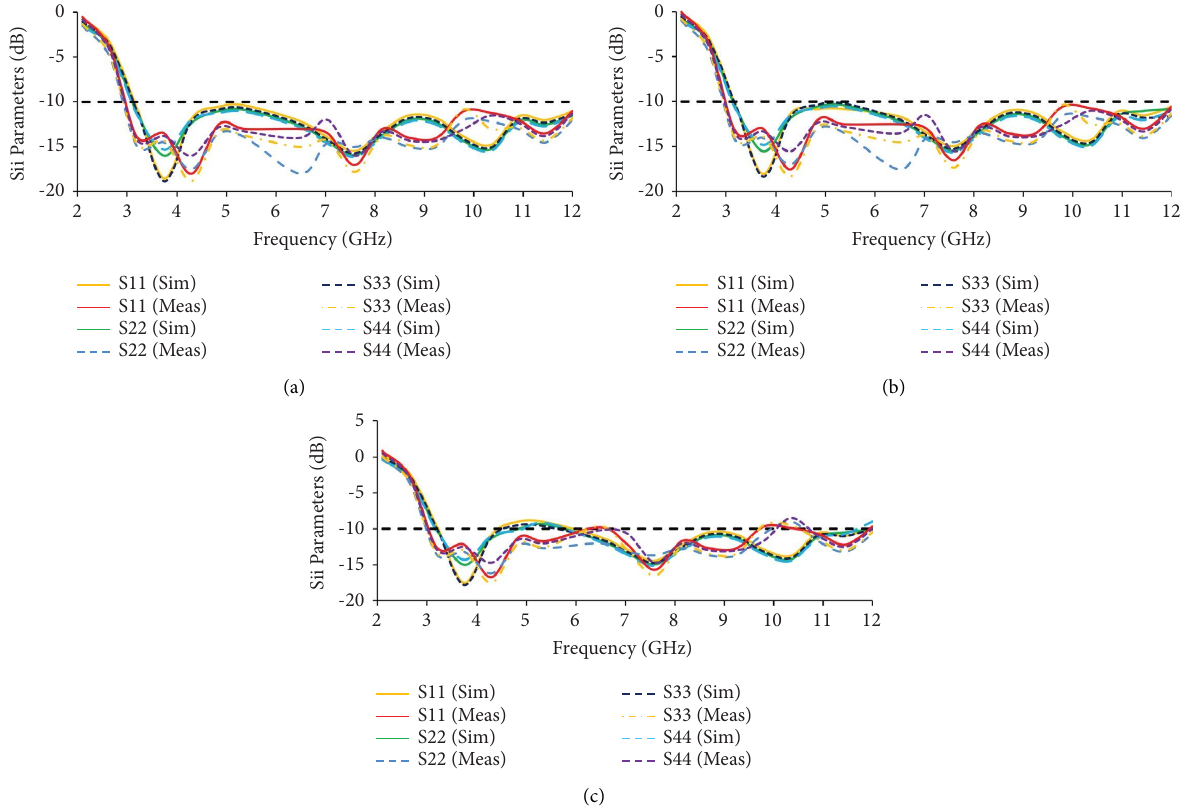
Figure 16: Refection coefcient plots in diferent bending scenarios: (a) r � 25 mm, (b) r � 20mm, and (c) r � 15mm.